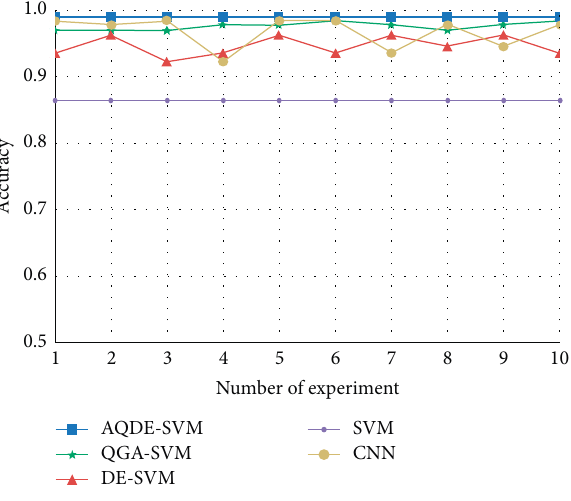
Figure 9: Accuracy of each